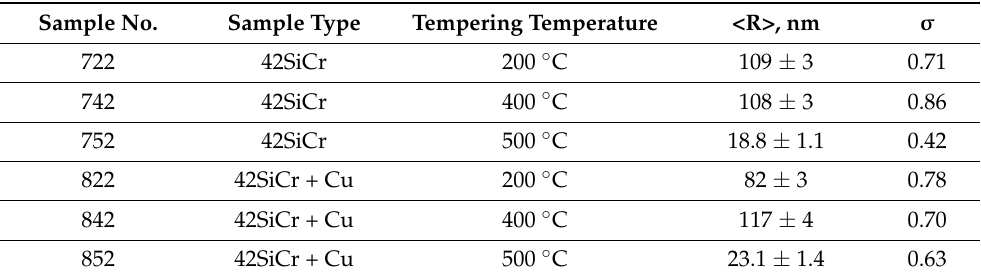
Table 6. Model parameters obtained by fitting the USANS data. <R> is the mean radius and σ is the width of the lognormal